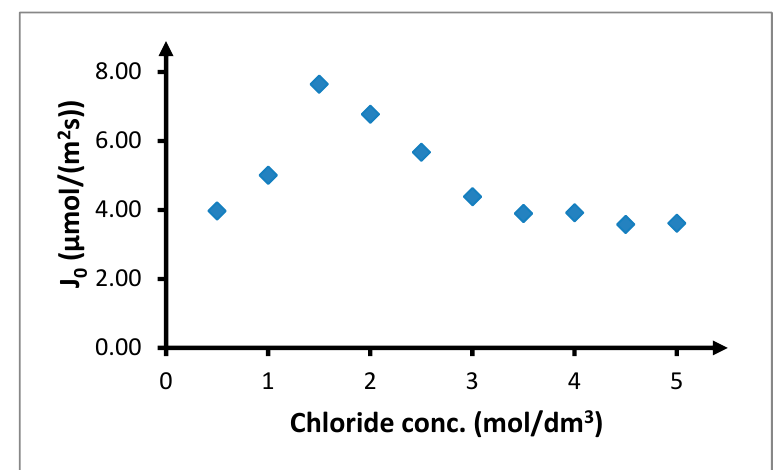
Figure 7. Initial copper(II) flux (J 0 , μ mol ∙ m − 2 ∙ s − 1 ) depending on concentration of chloride anions in feed phase. The volumetric flow rate is 3.0 cm 3 /min. Feed phase: CuCl 2 concentration = 0.1 mol/dm 3 , chloride concentration 0.5 = 5.0 mol/dm 3 ; receiving phase: demineralized water; and membrane: CTA-ONPOE-TRIA-10. The composition of the membrane is given in Table 2. Temperature 20 ± 0.5 °C.